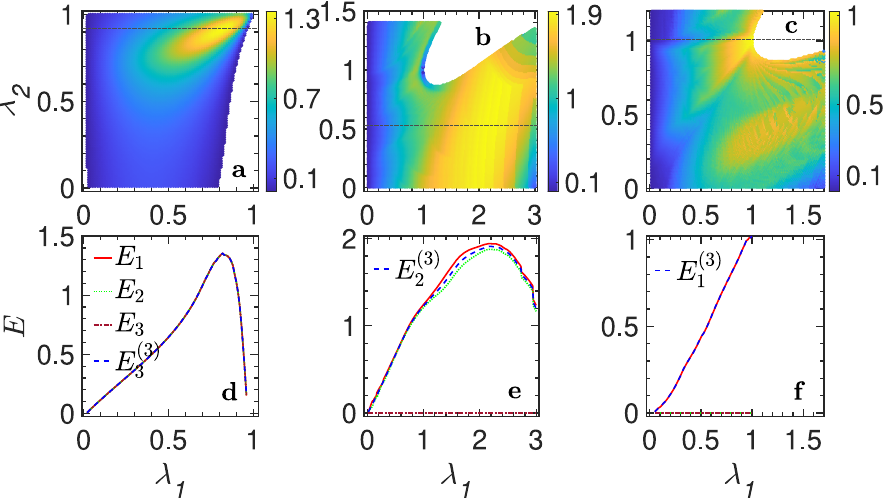
Fig. 4 Logarithmic negativity for triadic entanglement. Panels a – c show numerically optimized entanglement for a all bipartitions, E ð 3 Þ b two bipartitions, E ð 3 Þ , and c one bipartition, E ð 3 Þ . Panels d – f show cuts through the corresponding 2D plots for entanglement in d all 1 2 bipartitions for λ 2 = 0.92, e two bipartitions for λ 2 = 0.53, and f one bipartition for λ 2 = 1.01. System parameters for numerical simulations and colour coding are the same as in Fig.